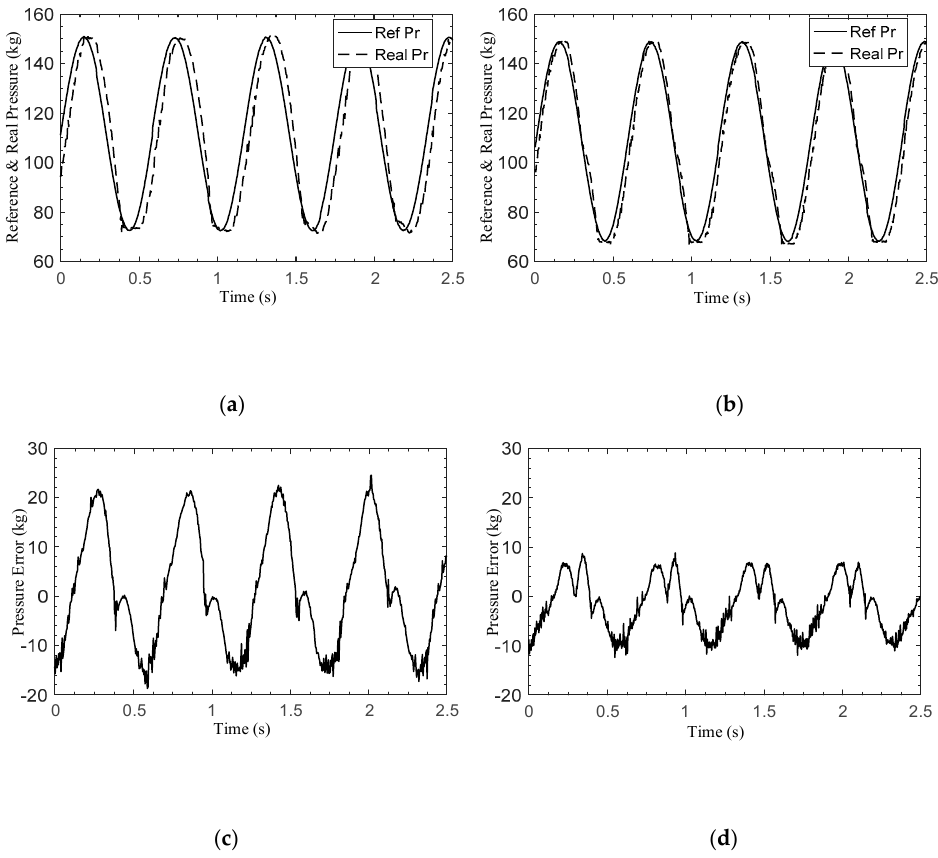
Figure 8. Comparison of EMA controller performance. ( a ) PID control; ( b ) proposed method; ( c ) error for PID control; ( d ) error for proposed method.